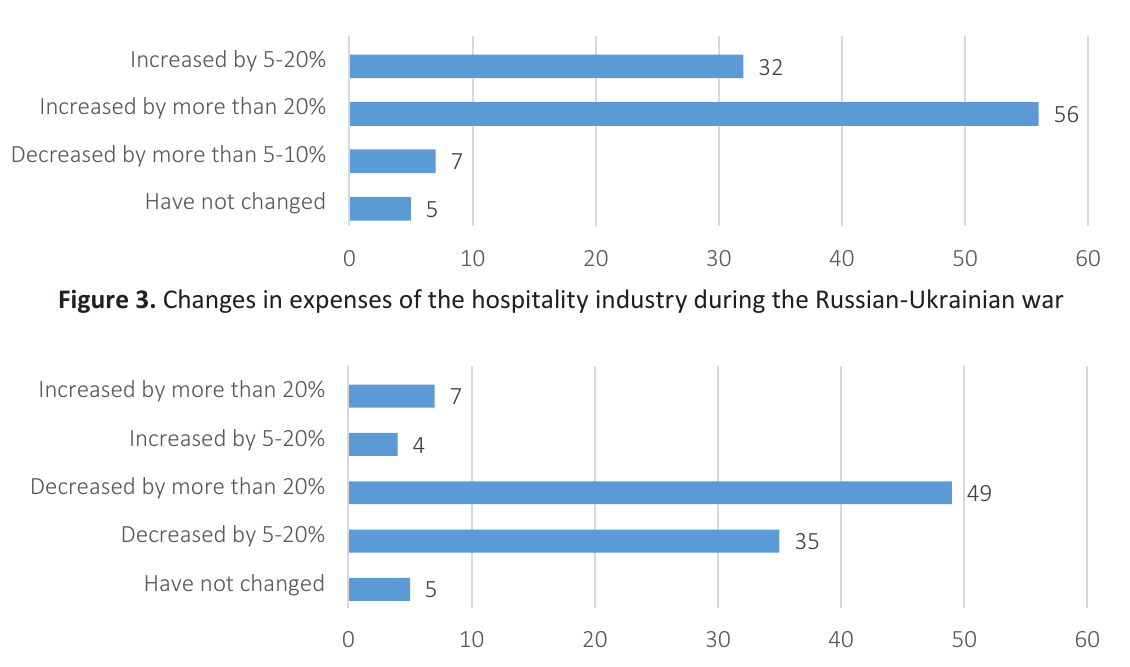
Figure 4. Changes in profits during the Russian-Ukrainian war